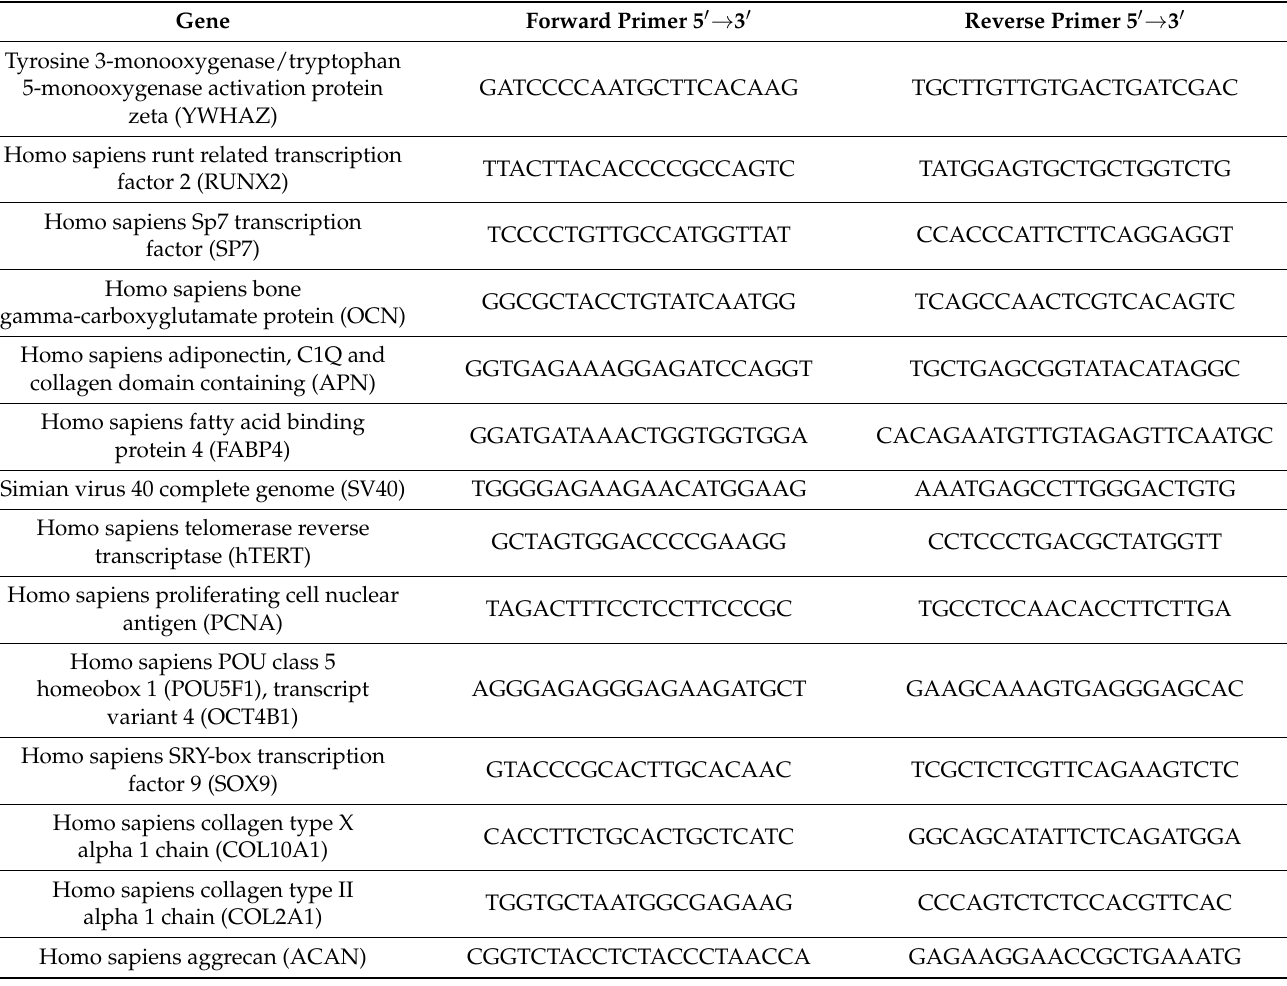
Table 3. Studied genes and respective primers employed for quantitative real-time PCR (qPCR) analysis.